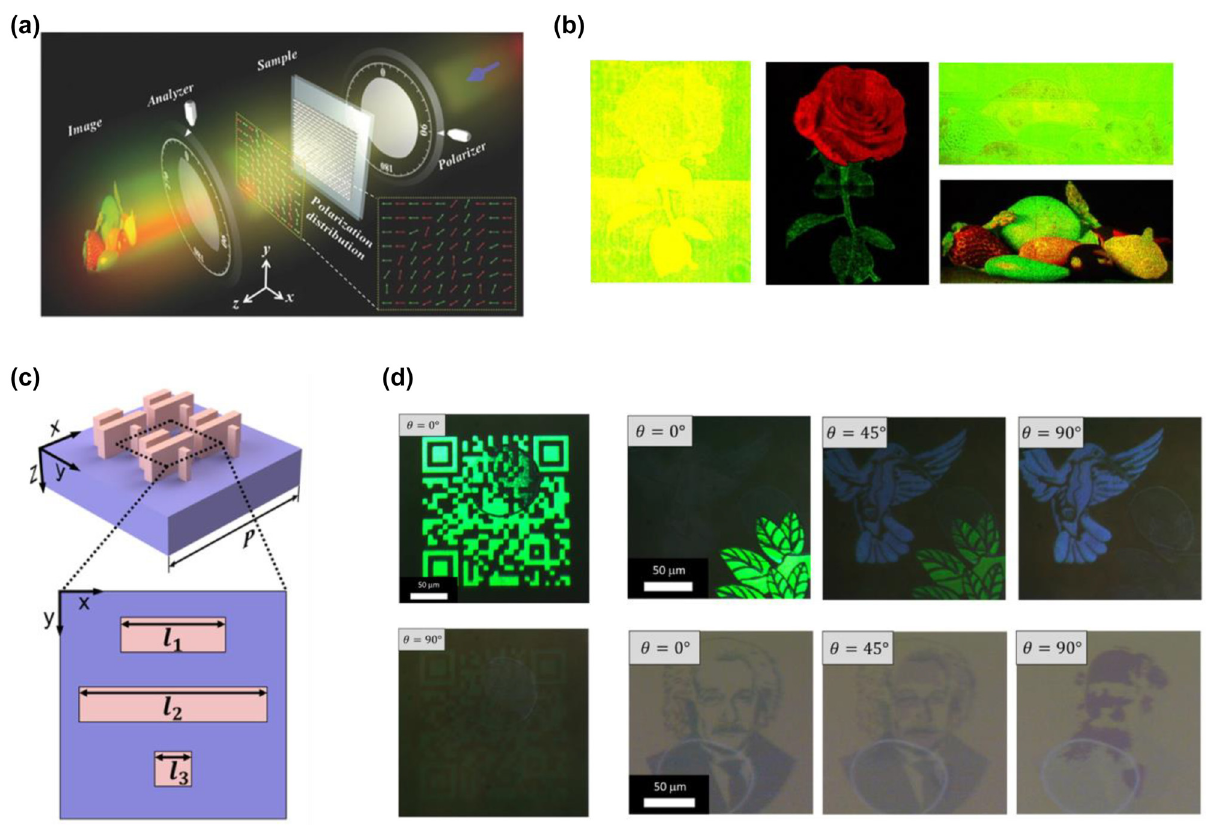
Figure 38: Full-color encryption based on polarization-sensitive structural coloration. (a) Schematic of the polarization encryption setup. A linear polarizer in front of the metasurface generates a linearly polarized light, and the metasurface consisting of miniature half-wave plates can modulate the linearly polarized incident light into a transmitted light with a collection of spatially-varying polarization states. The output linear polarizer (analyzer) with its transmission axis perpendicular to that of the input polarizer transforms the light beam from the metasurface into a color image. (b) Color images by means of polarization encryption without (the left and the upper right images) and with (the middle and the lower right images) the required analyzer. Modified with permission [344]. Copyright 2018, Wiley-VCH. (c) Schematic of the resonant unit consisting of a triple-nanofin structure of the same height, width and separation, but of varying lengths. (d) Left panel: micrographs of a QR code. Right panel: dual-color images of a blue bird on green leaves (upper row) and overlapped dual-portrait images (lower row). The appearance of these images changes as the polarization angle ( 𝜃 ) of incident light rotates. Modified with permission [345]. Copyright 2021, Walter de Gruyter